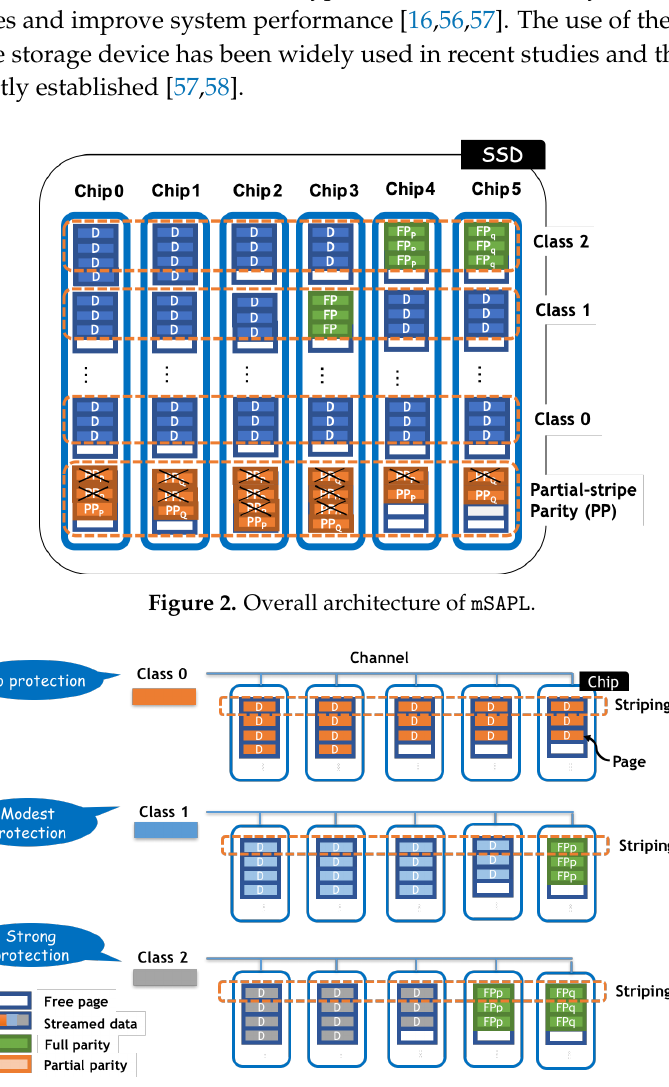
Figure 3. Example of multi-level protection with mSAPL